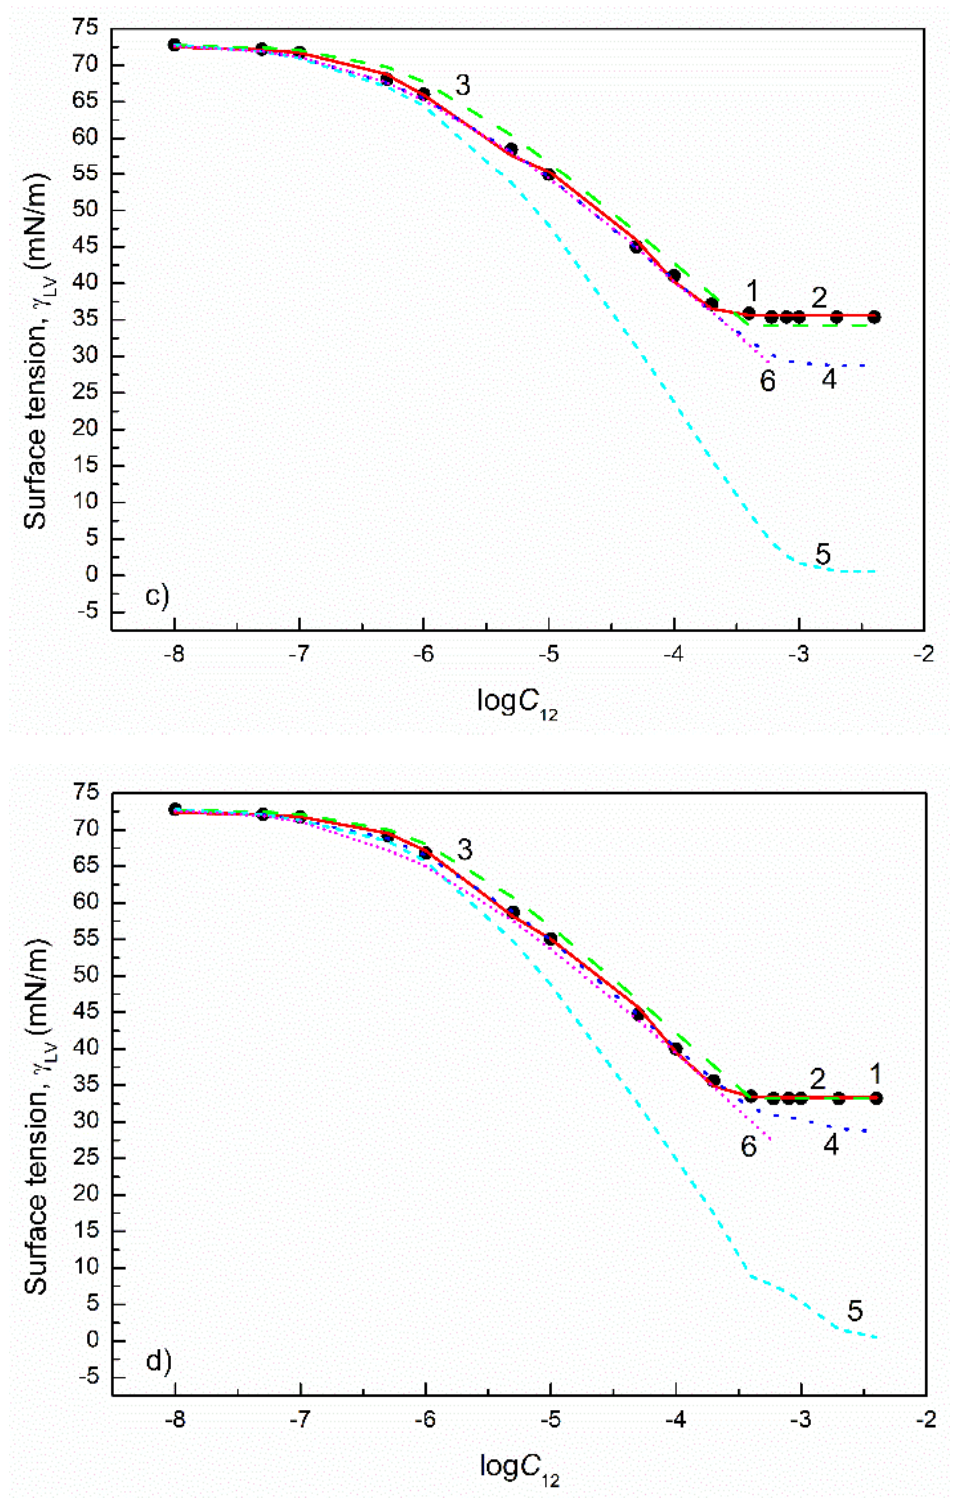
Figure 7. A plot of the surface tension ( 𝛾 𝐿𝑉 ) of the aqueous solutions of TX100+TX165 mixtures at the TX100 mole fraction in the bulk phase ( 𝛼 ) equal to 0.2 ( a ), 0.4 ( b ), 0.6 ( c ) and 0.8 ( d ) vs. the logarithm of the mixture concentration ( 𝑙𝑜𝑔𝐶 12 ). Points 1 correspond to the measured values [22], curves 2 – 6 correspond to the values calculated from the exponential function of the second order (Equation (2)), Szyszkowski equation (Equation (3)), Fainerman and Miller equation (Equation (11)), independent adsorption (Equation (10)) and Joos equation (Equation (13)), respectively.